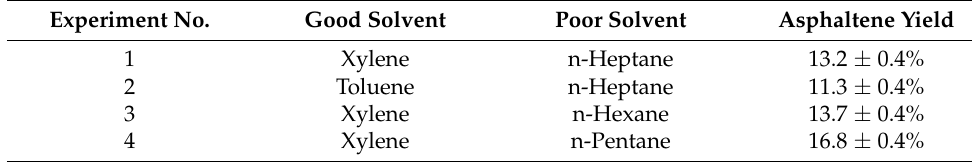
Table 5. Asphaltene yields in different good and poor solvents. Experiment